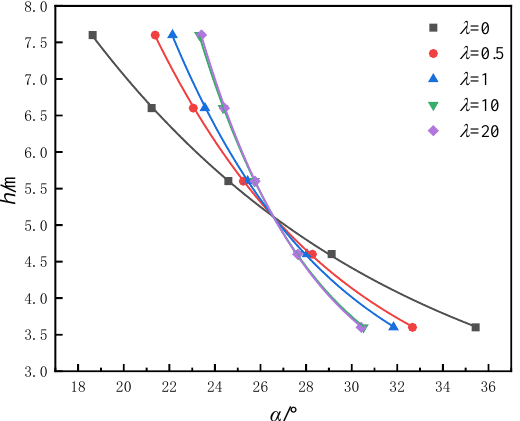
Figure 6. Relationship between support height h and limit angle α .